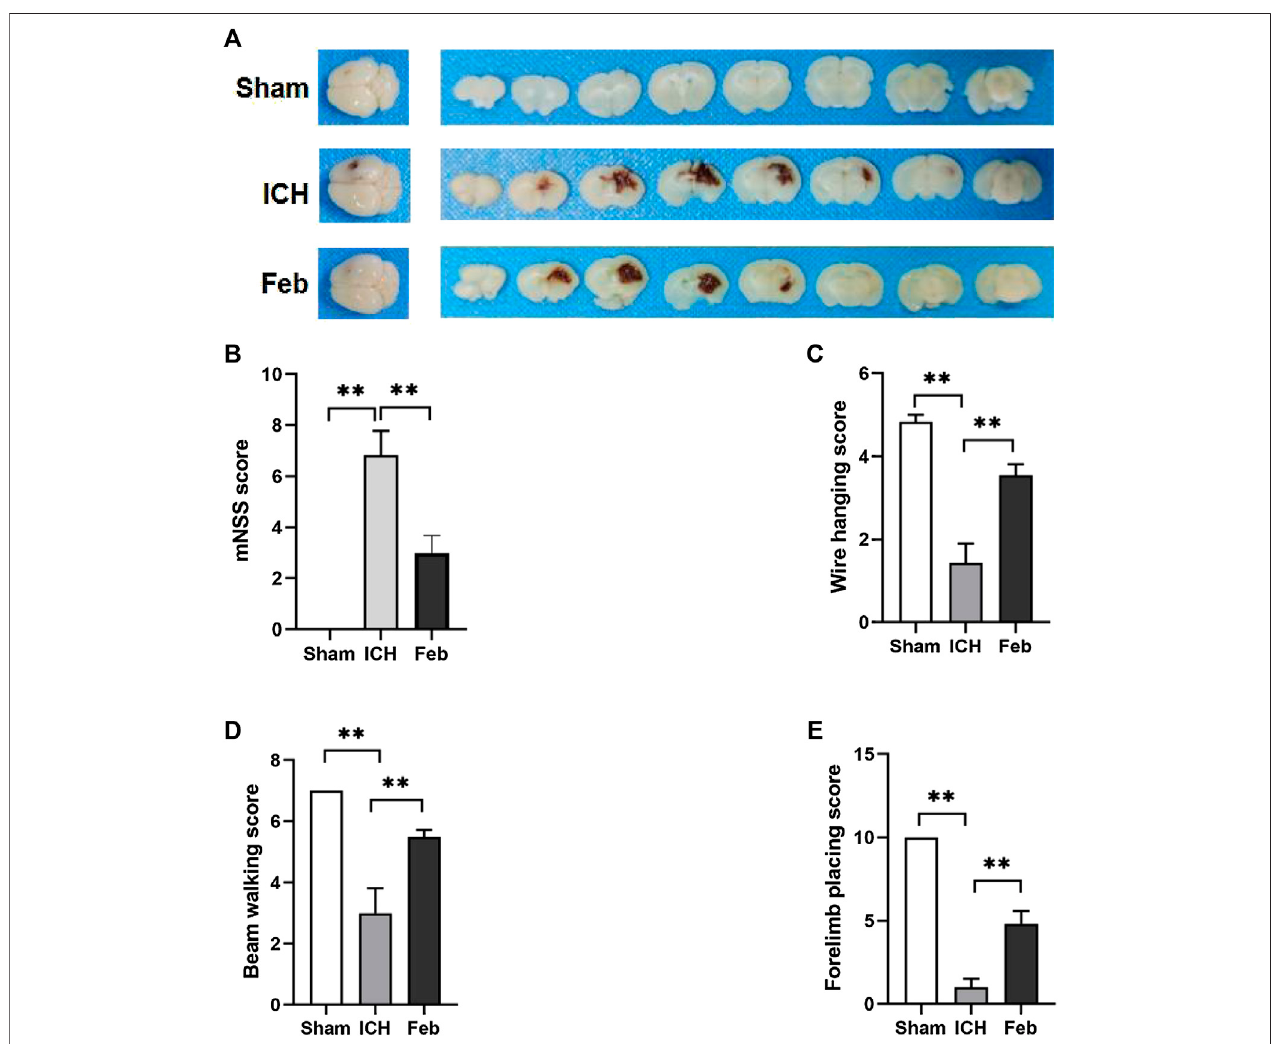
FIGURE1| FebuxostatimprovedneurologicaldysfunctionafterICH: (A) Representativeimagesofcoronalbrainsections; (B) Modi fi edneurologicalseverityscore. (C) Wire hanging test. (D) Beam walking test. (E) Forelimb placing test. Values are mean ± S.E.M; ** p < 0.01 ( n = 6 mice/group, two-way ANOVA).